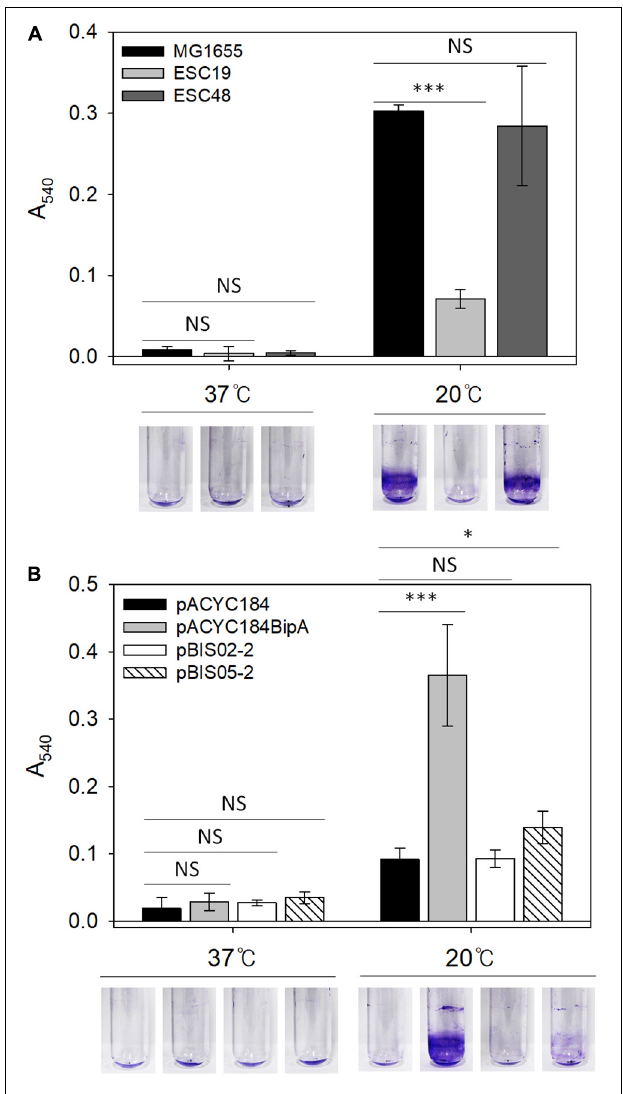
FIGURE 6 | Biofilm formation assay of MG1655, ESC19, and ESC48 strains (A) and ESC19 transformants with pACYC184, pACYC184BipA, pBIS02-2, or pBIS05-2 (B) . Cells were grown in 2.5 ml of LB broth with appropriate antibiotics at 37 ◦ C for 24 h or 20 ◦ C for 48 h. Then, biofilm biomass on inner surface of glass tube was stained with 0.1% crystal violet and dissolved in 95% ethanol. The absorbance of the resulting dissolved dye was measured at a wavelength of 540 nm. A representative photograph is shown from three independent experiments. Error bars represent SD using three replicates. NS, non-significant; ∗ p < 0.05; ∗∗∗ p <